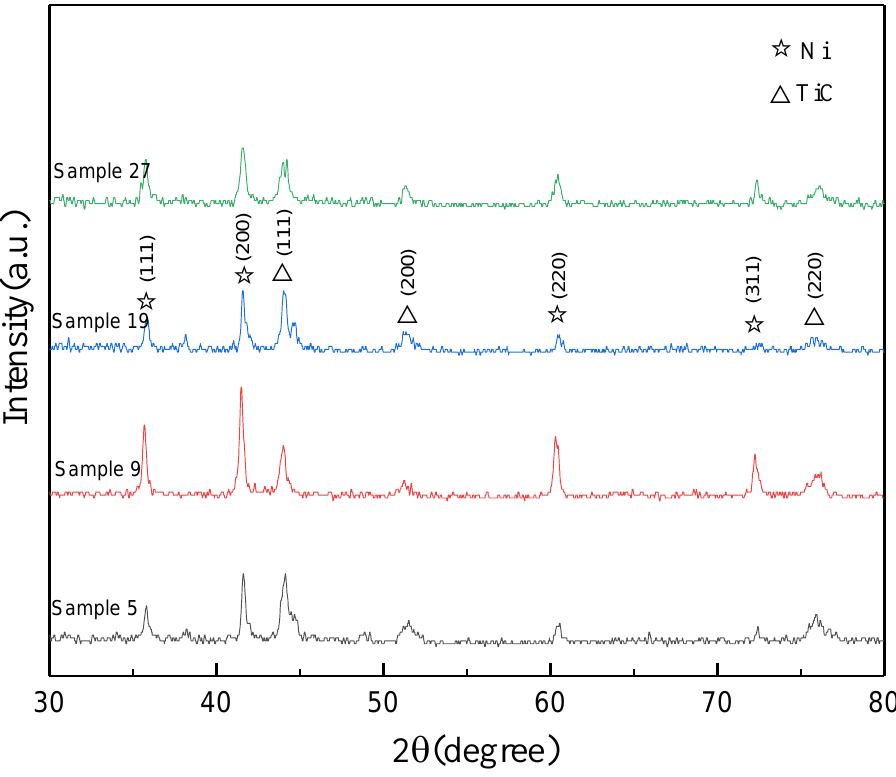
Figure 13. Impact of different parameters on wear volume.